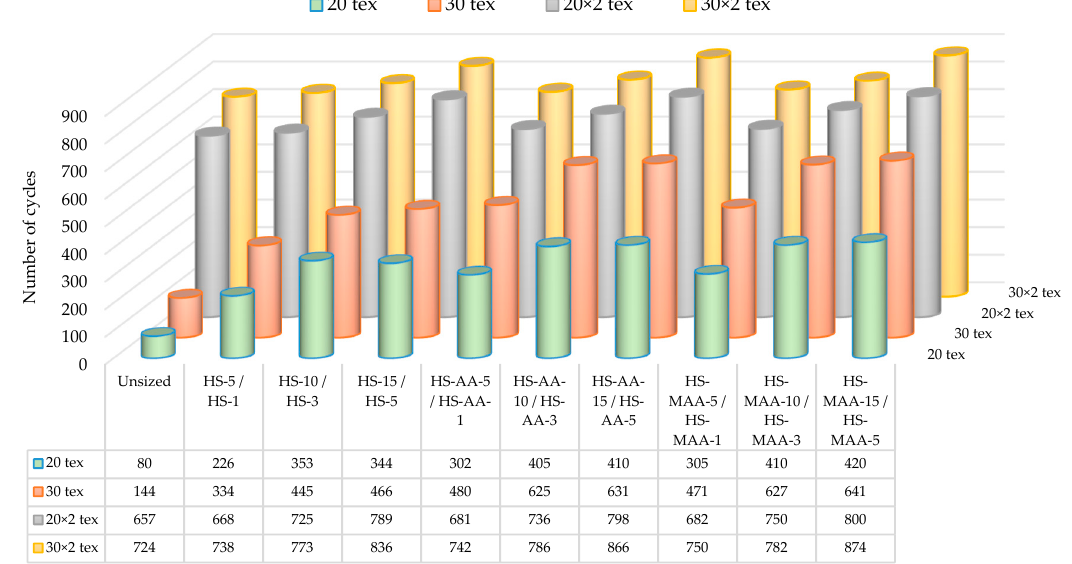
Figure 3. Yarn abrasion resistance during the sizing process.